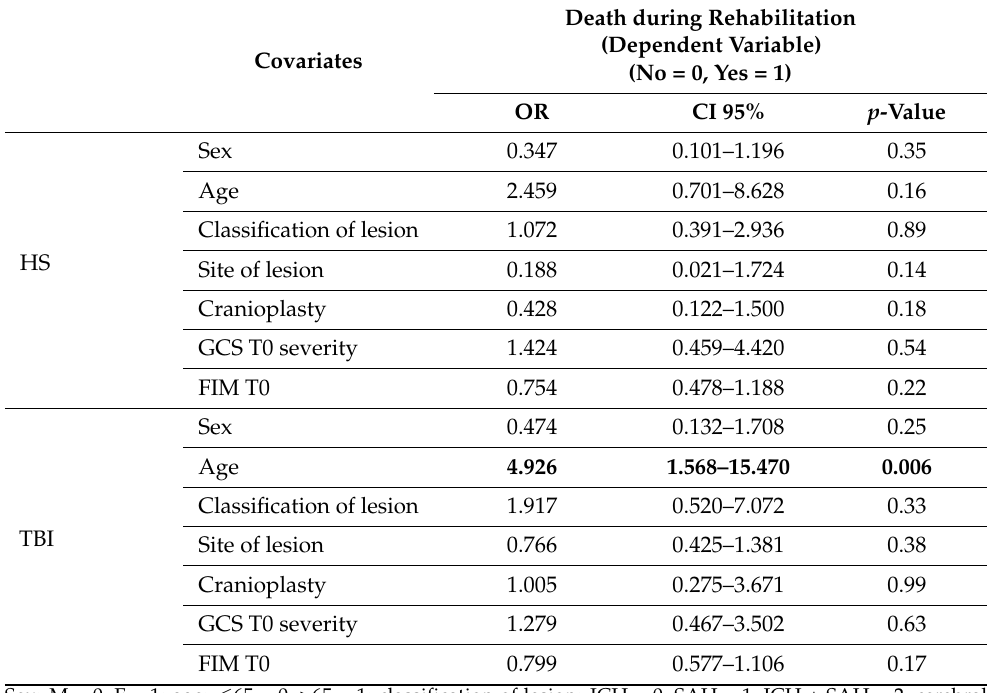
Table 4. Multivariable logistic regression analysis showing the potential risk factors for mortality within 6 months of brain